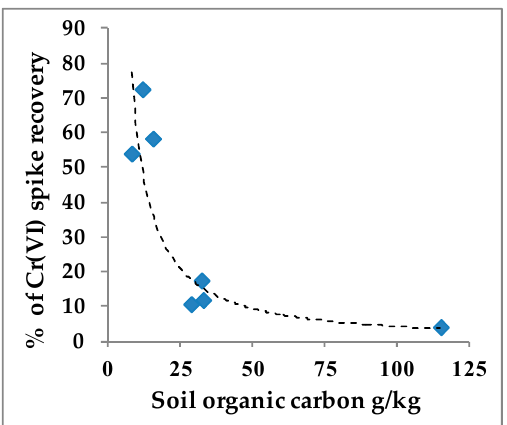
Figure 5. Percent of Cr(VI) spike recovery in the function of the soil organic carbon content. Table 6. Hydrocarbon speciation according to the MADEP approach on nine randomly selected soil samples.